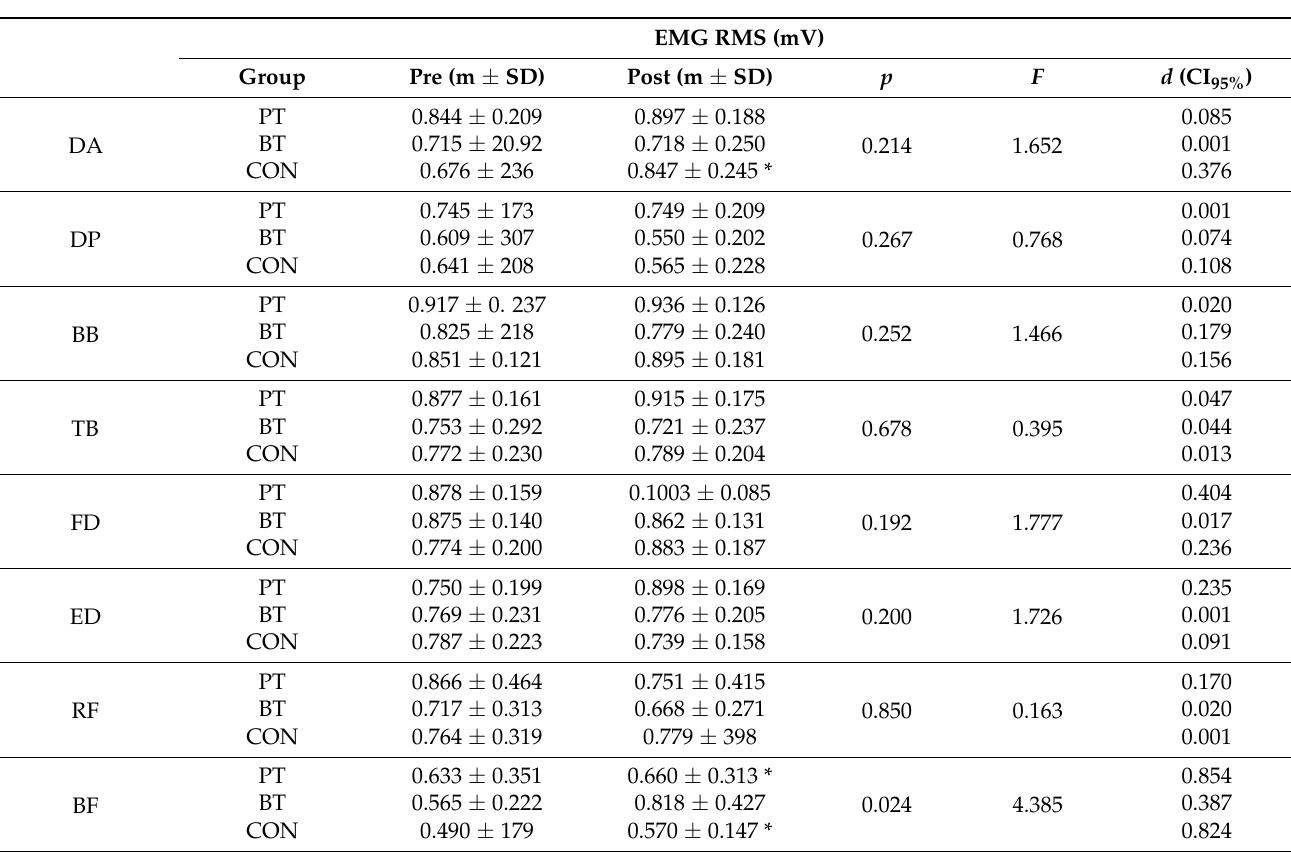
Table 4. Changes in the EMG root mean square (RMS) in each muscle during the maximum muscle excitability test after the 8-week